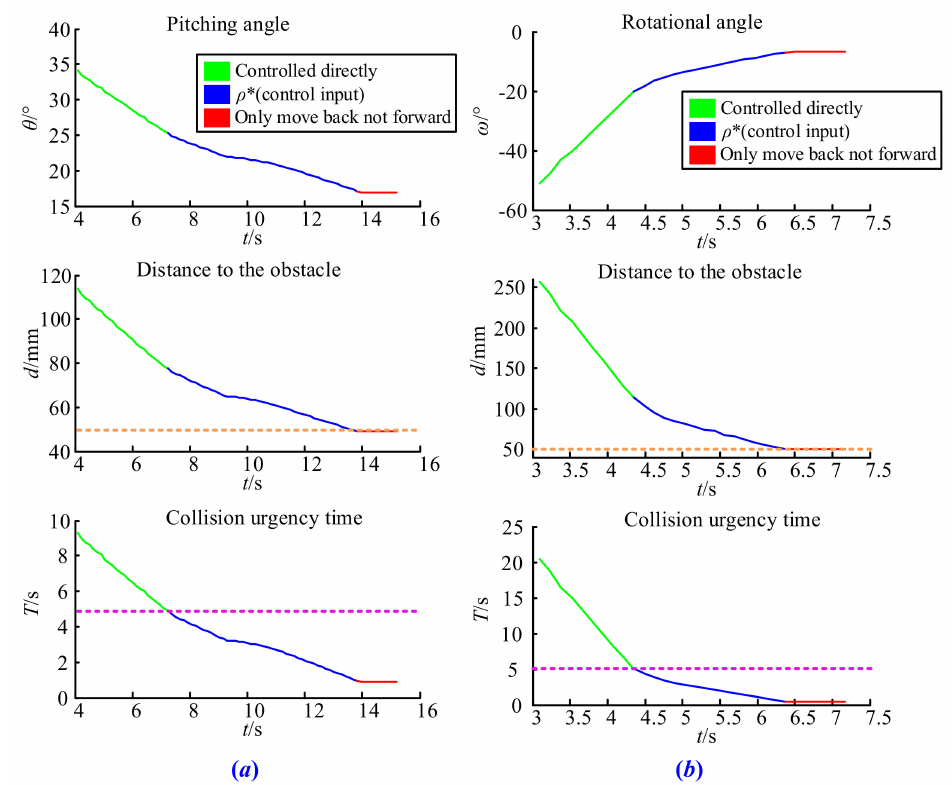
Figure 12. Result of the pitching and rotating test: ( a ) pitching test, ( b ) rotating